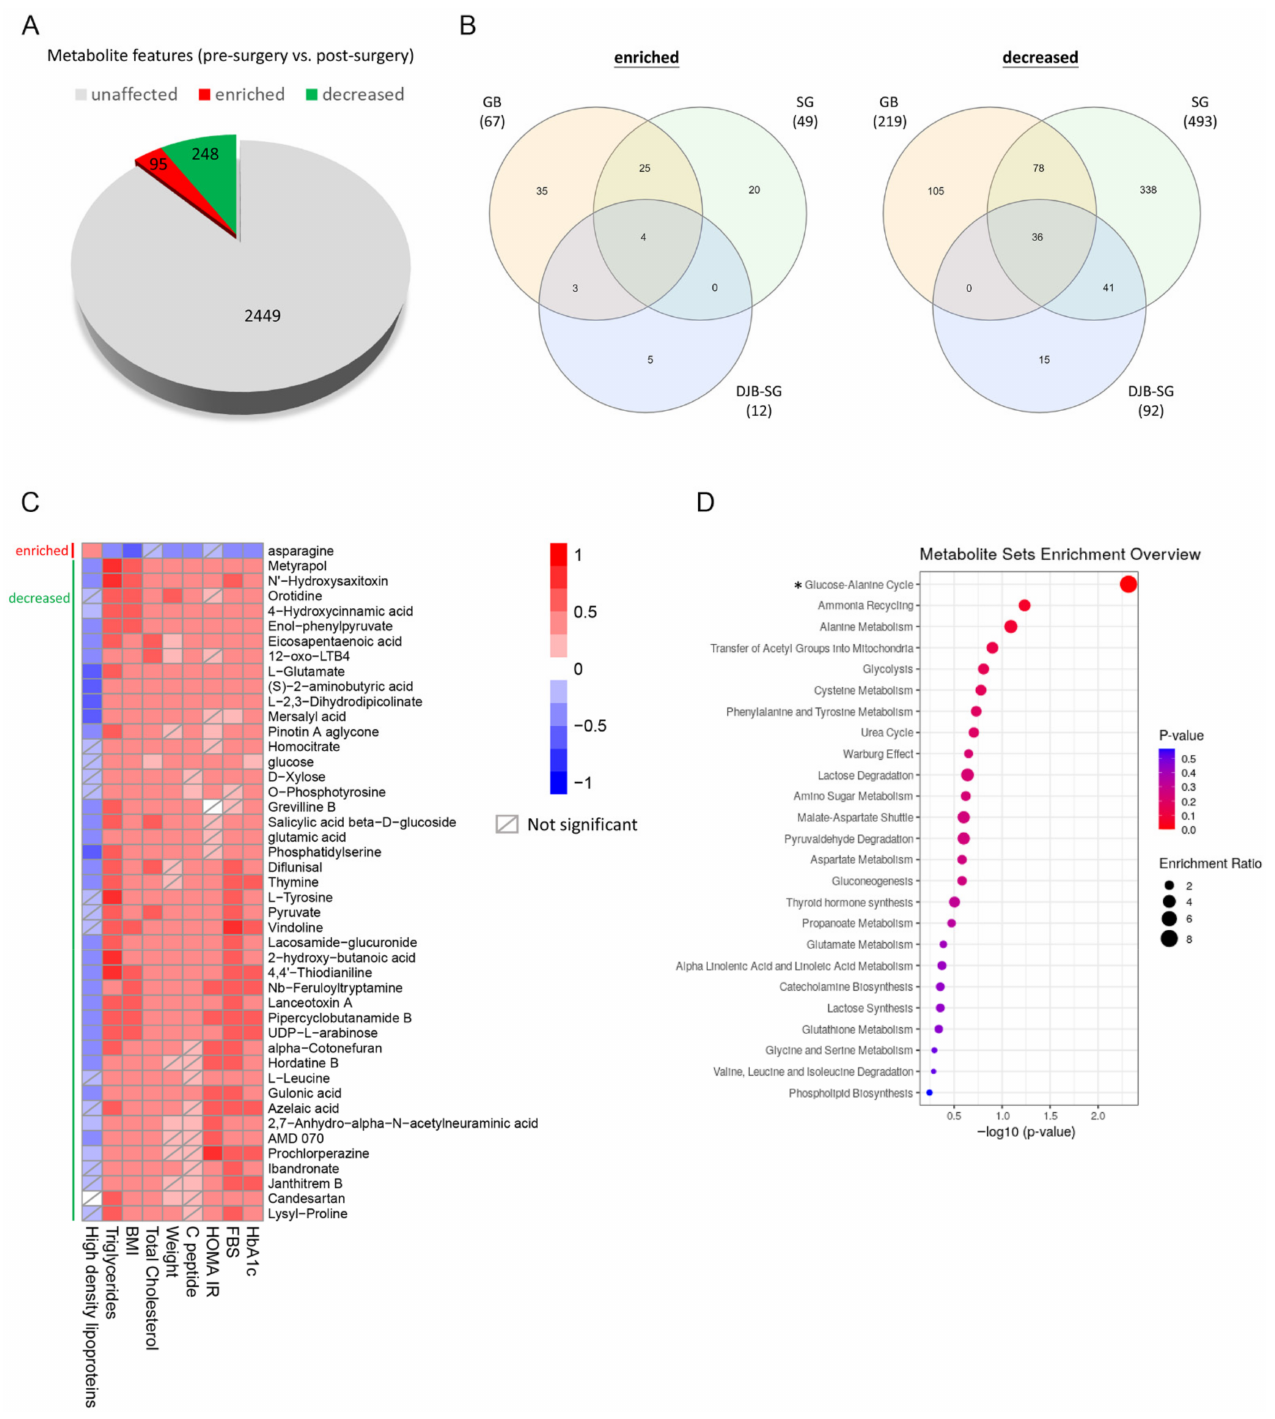
Figure 2. Changes in the serum metabolites after metabolic surgery. ( A ) Differential expressed metabolite features after surgery. Pre-surgery and post-surgery sera metabolite features identified by using an untargeted metabolomic platform gas chromatography-mass spectrometry (GC-MS) and liquid chromatography-mass spectrometry (LC-MS) were annotated and compared. After metabolic surgery, 95 annotated metabolite features were enriched, and 248 features were decreased (adjusted p < 0.05). ( B ) Venn diagrams showed the numbers of common and unique metabolites altered in patients after having three different metabolic surgery techniques (GB, laparoscopic gastric bypass; SG, laparoscopic sleeve gastrectomy; DJB–SG, laparoscopic duodenal-jejunal bypass with sleeve gastrectomy). ( C ) Correlation between differential-expressed metabolites and clinical